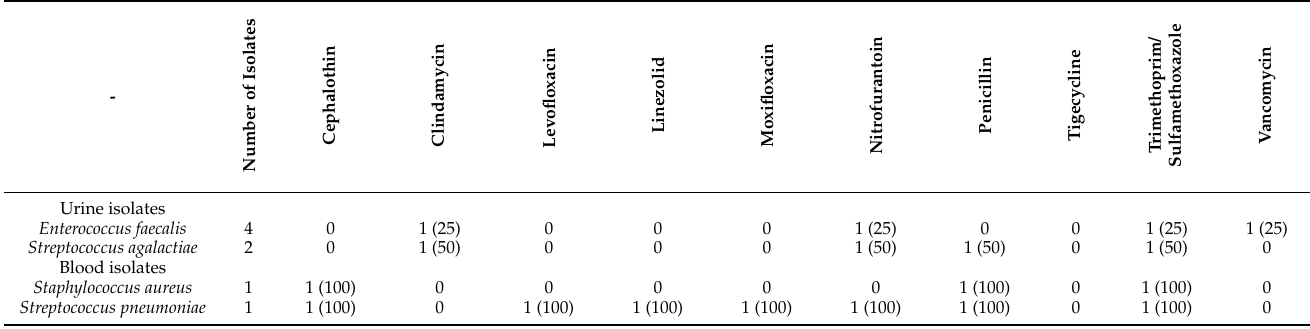
Table 3. Resistance profiles of Gram-positive bacteria isolated from neonates with urinary